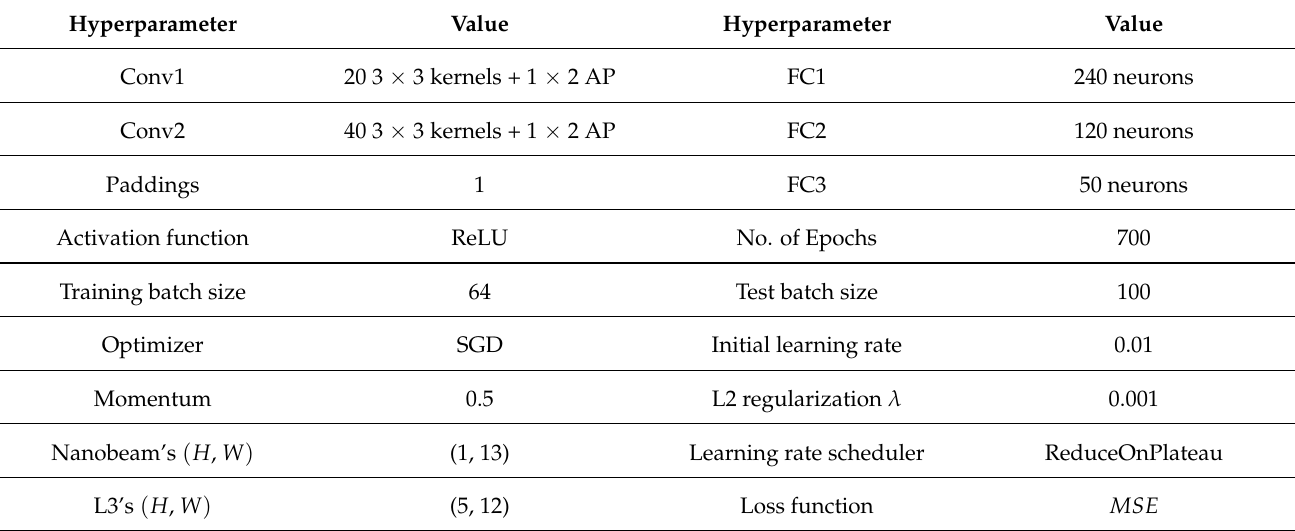
Figure 2. Pictorial illustration of the working principle of convolutional neural networks (CNN) with average pooling. Moreover, the formula for calculating the output feature size of a convolutional operation is also shown. Table 1. Hyperparameters of